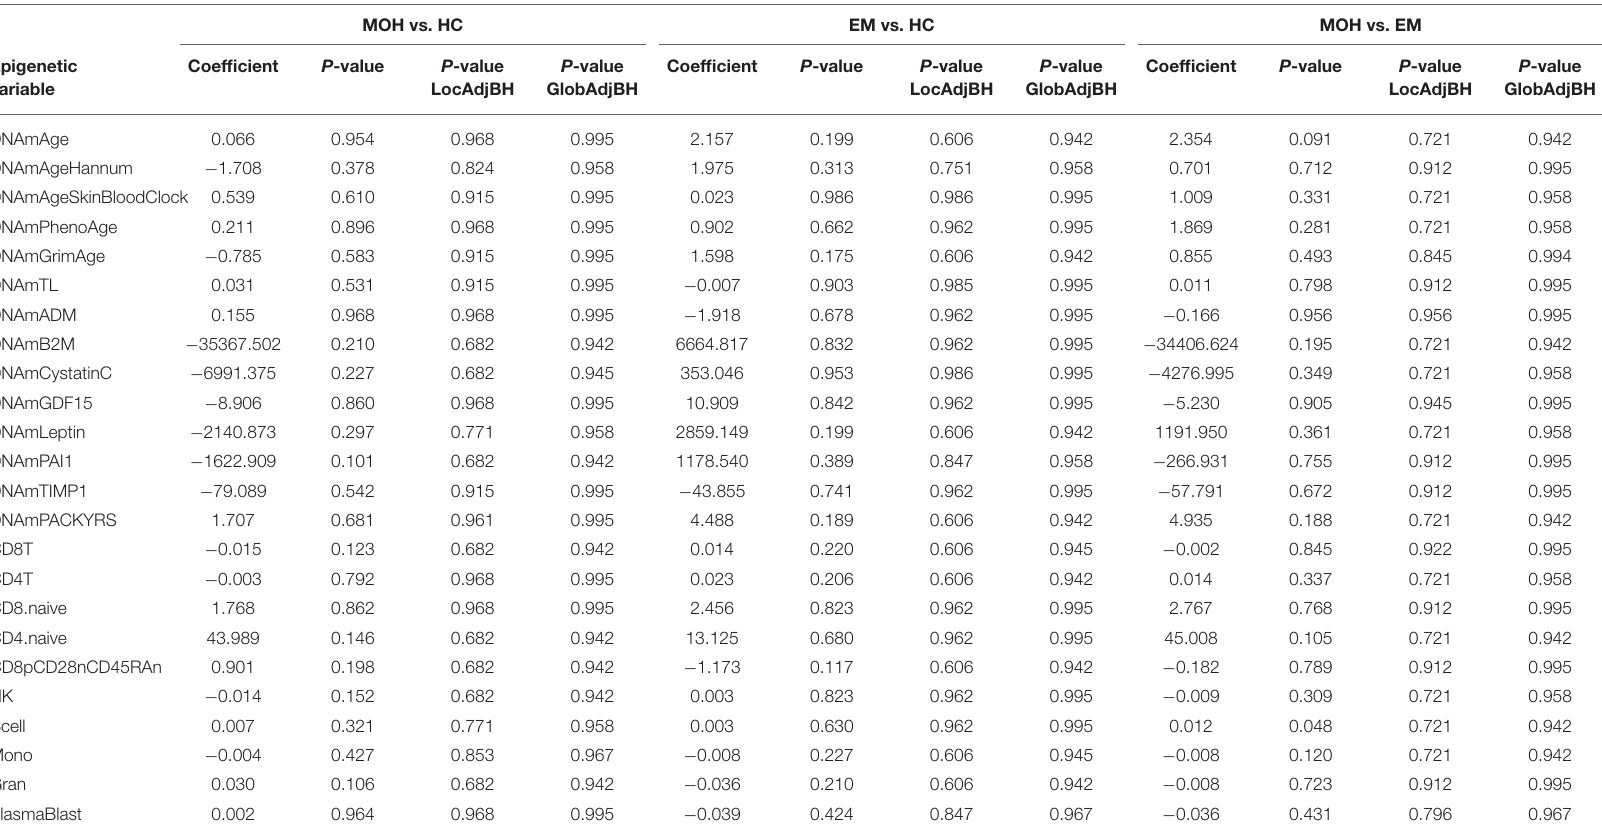
TABLE 6 | Results of statistical hypothesis testing comparing MOH patients, EM patients, and healthy individuals (HC), using the MLR approach correcting for chronological age. MOH vs. HC EM vs. HC MOH vs.